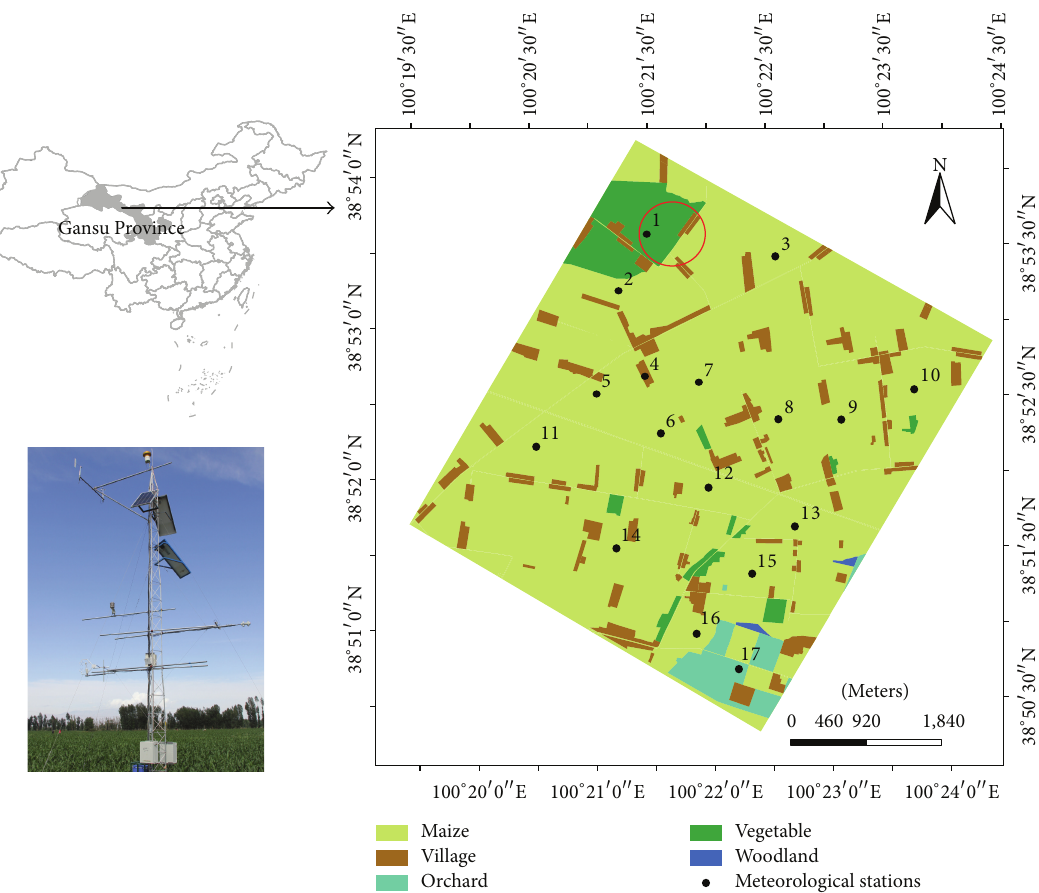
Figure 2: Land use status in the study area and spatial distribution of meteorological stations.